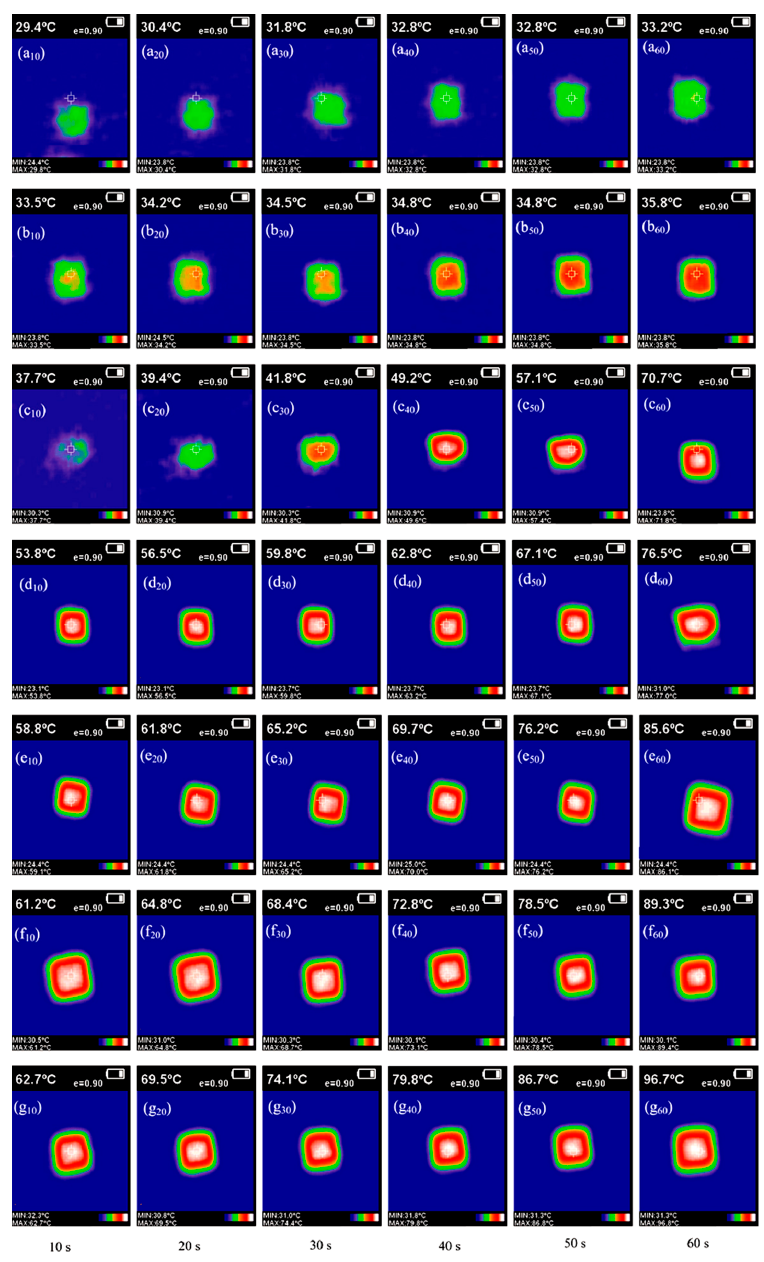
Figure 13. Infrared thermograph (IRT) results of the thermal transmission of various microPCM samples with/without graphene, each microPCM sample (5 g) was put on a constant temperature heating plate with temperature of 100 °C in 60 s, ( a 10 – a 60 ) MG-0; ( b 10 – b 60 ) MG-1; ( c 10 – c 60 ) MG-2; ( d 10 – b 60 ) MG-4; ( e 10 – e 60 ) MG-6; ( f 10 – f 60 ) MG-8; and ( g 10 – g 60 )